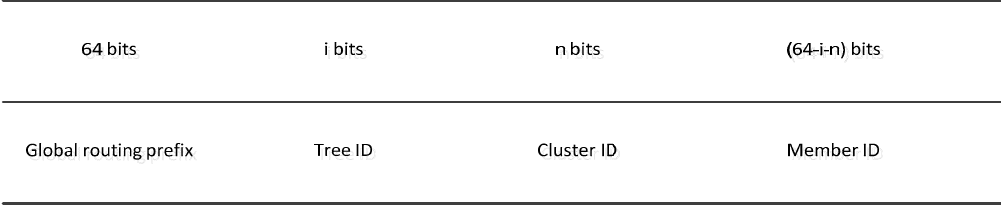
Figure 6. The IPv6 address structure using cluster-based addressing (adapted from [13]).